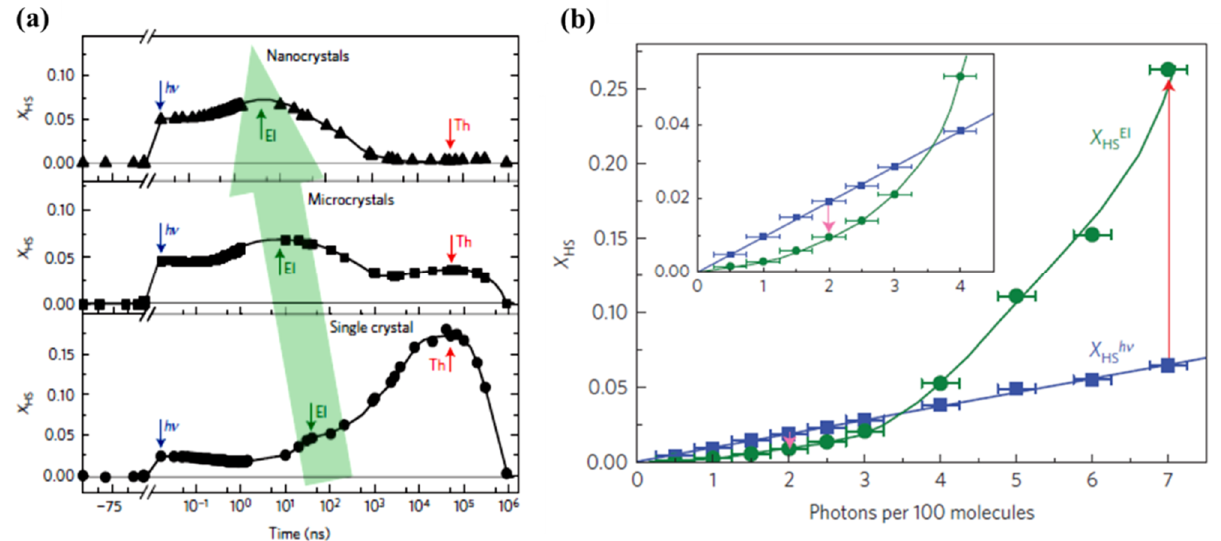
Figure 9. ( a ) The response of different sizes of low spin Fe III (3-MeO-SalEen) 2 ]PF 6 crystals to a femtosecond laser excitation, top panel: nanocrystals, middle panel: microcrystals, and bottom panel: single crystals. The photoinduced step, the elastic step, and the thermal step are denoted as, h ν , El, and Th respectively. The green arrow indicates the elastic step shift towards the shorter time scale with the crystal size reduction. ( b ) The high spin fraction XHS formation due to photoinduced (measured at 10 ps) and elastic step (measured at 100 ns) with laser excitation energy density scaled in photons per 100 molecules. Reprinted with permission from Ref. [59]. Copyright 2016 Springer Nature.